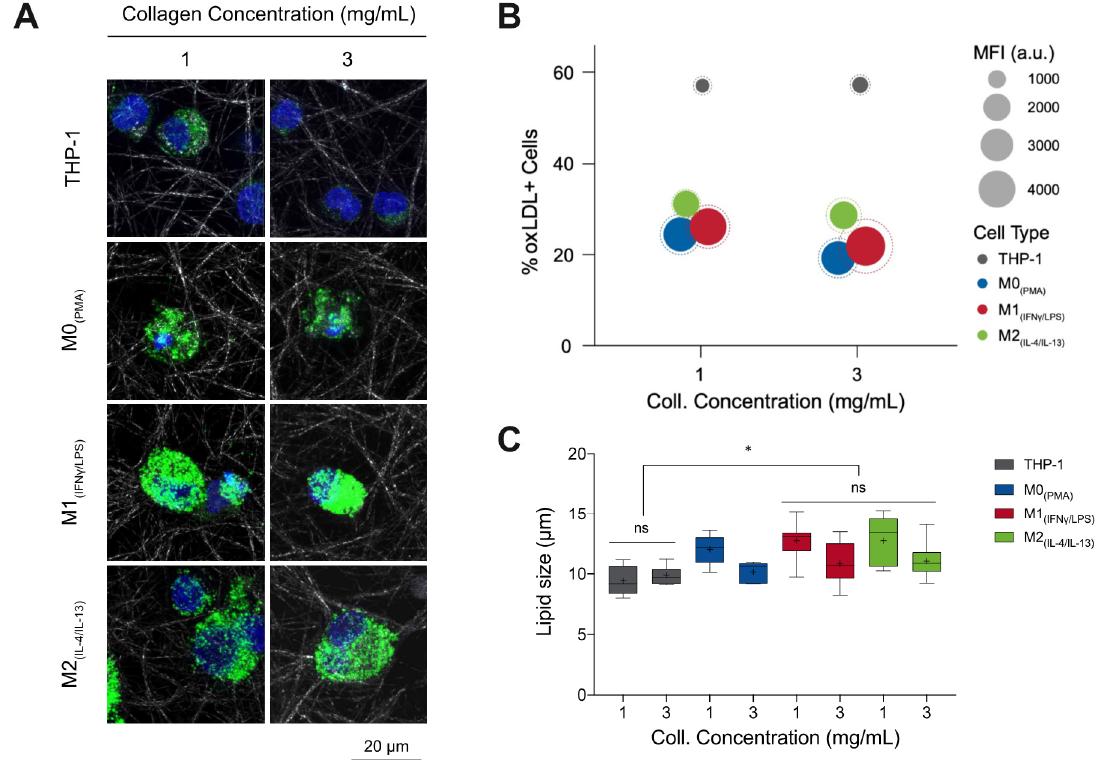
Figure 1. oxLDL uptake by monocytes and macrophages in 3D collagen matrices. ( A ) Representative confocal images of monocytes and macrophages with DiI-oxLDL uptake. ( B ) In this infographic, the number of oxLDL + cells ( y -axis) was greatest in THP-1 (grey) followed by M2 (green) macrophages, then M1 (red), and finally M0 (blue). The amount of oxLDL in the cells, as quantified through mean fluorescence intensity (MFI, solid circle) (circle size, see legend), was greatest in M1 macrophages, followed by M0, then M2, and finally THP-1. The dotted circle is the corresponding standard deviation of the MFI. A sample size of 5 was performed for each condition. ( C ) Lipid droplet size as measured from images obtained with confocal microscopy using a custom-built image analysis toolbox. Data were shown as a boxplot (whiskers represent minimum and maximum, + represents the mean, line inside each box plot represents the median). Significance is represented as * p < 0.05 between samples in 1 mg/mL collagen concentration.